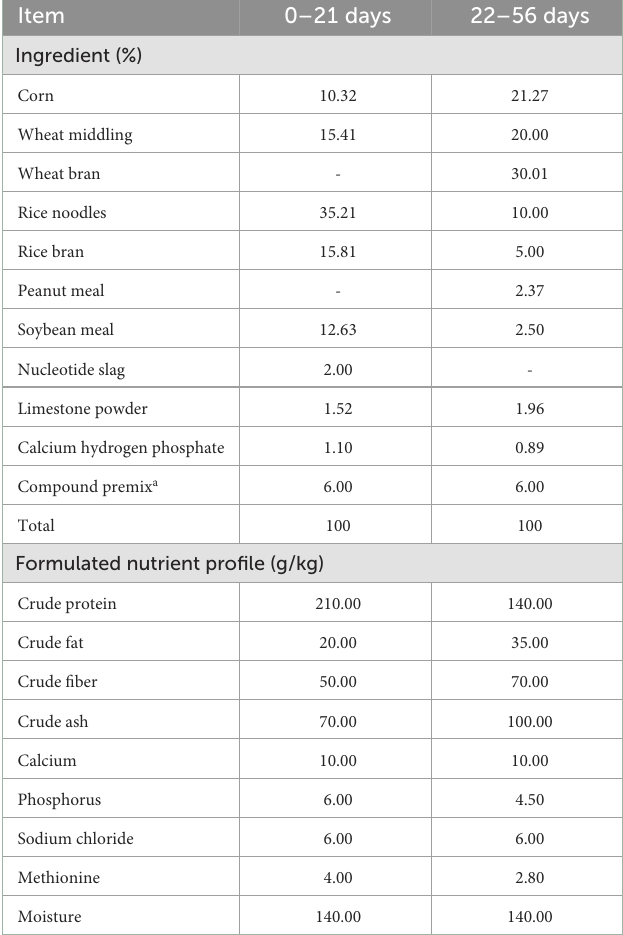
TABLE 1 Compositions of and nutrients in the experimental